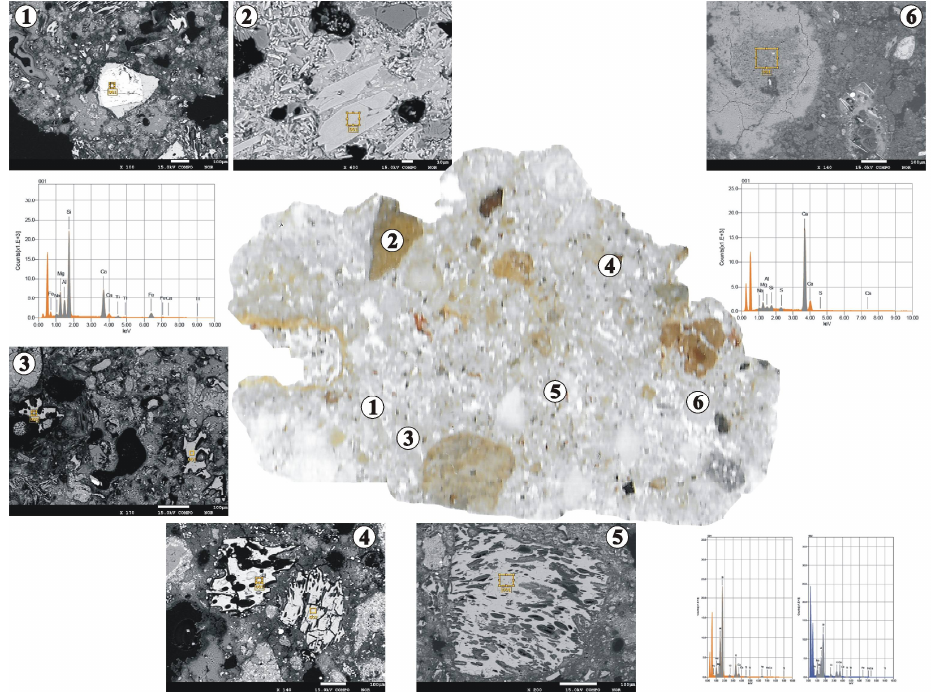
Figure 6. Representative EMPA-EDS images showing some morphological features and investigated areas within CN-10 sample: 1 and 2, clinopyroxene crystals and corresponding EDS spectrum; 3, 4, and 5, glassy scoriae, pumice fragments, and corresponding EDS spectra; 6, analyzed lime lump.